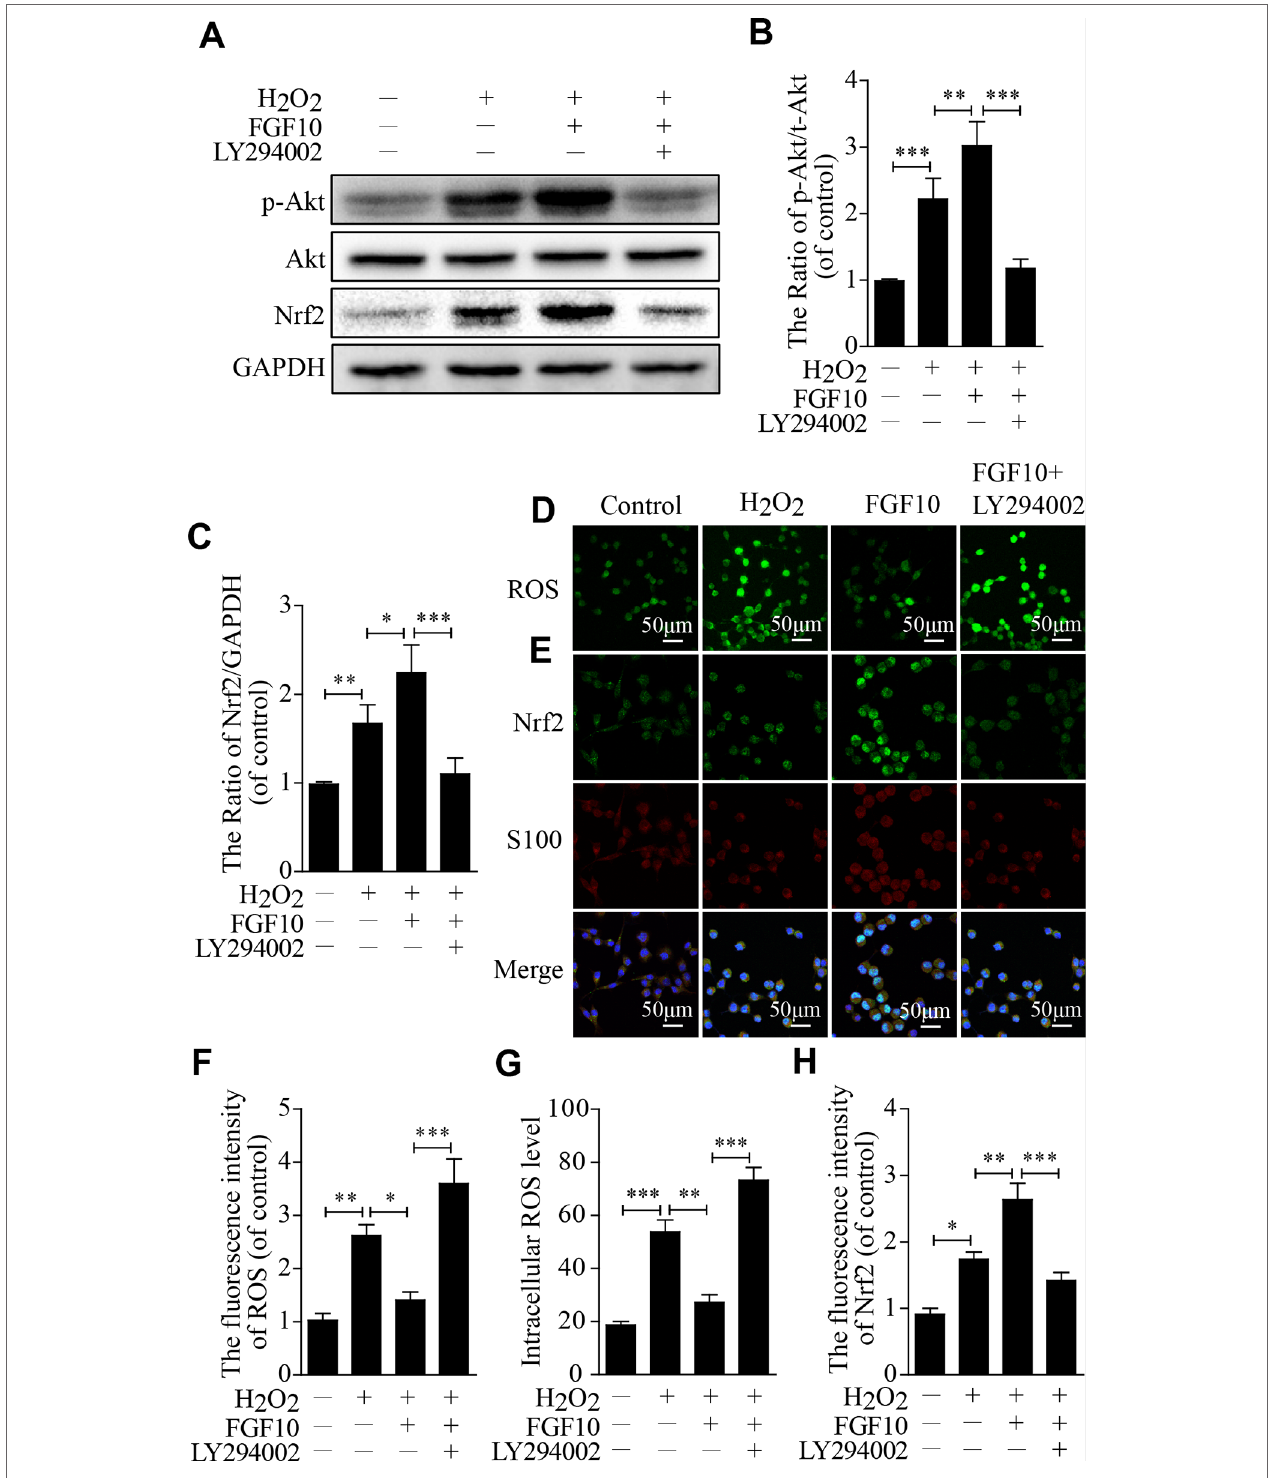
FIGURE 7 | Fibroblast growth factor 10 (FGF10) has antioxidant effects through the activation of the PI3K/Akt pathway in vitro . (A – C) Then, quantification of p -Akt, Akt, and Nrf2 expression was determined by western blotting in Schwann cells (SCs) . (D) Immunofluorescence staining of reactive oxygen species (ROS) labeled by dichlorodihydrofluorescein diacetate (DCFH-DA) in SCs. (E) Double immunofluorescence of Nrf2 (green) and S100 (red) in each group. Scale bar = 50 μm. (F – H) Statistical analysis of the ROS and Nrf2 levels in each group. These data represent the means ± SEM, n = 3. Control group vs H 2 O 2 group: * P < 0.05, ** P < 0.01, *** P < 0.001. FGF10 group vs H 2 O 2 group: * P < 0.05, ** P < 0.01. FGF10 group vs H 2 O 2 +LY294002 group: *** P <